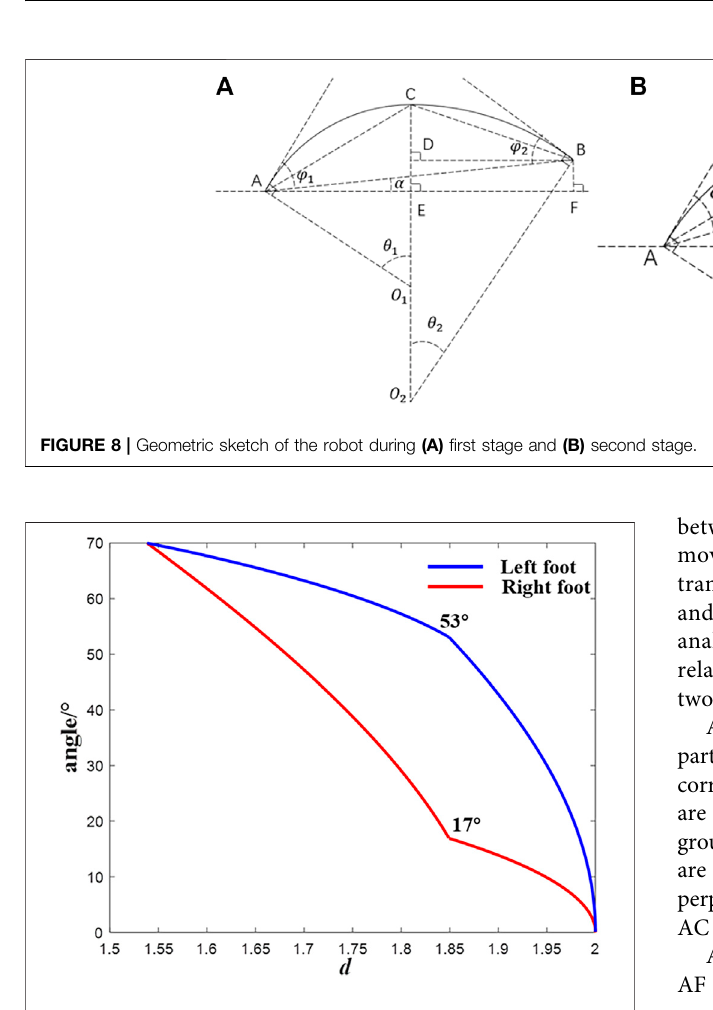
FIGURE 9 | Relationship between the contact angle and two feet ’ s